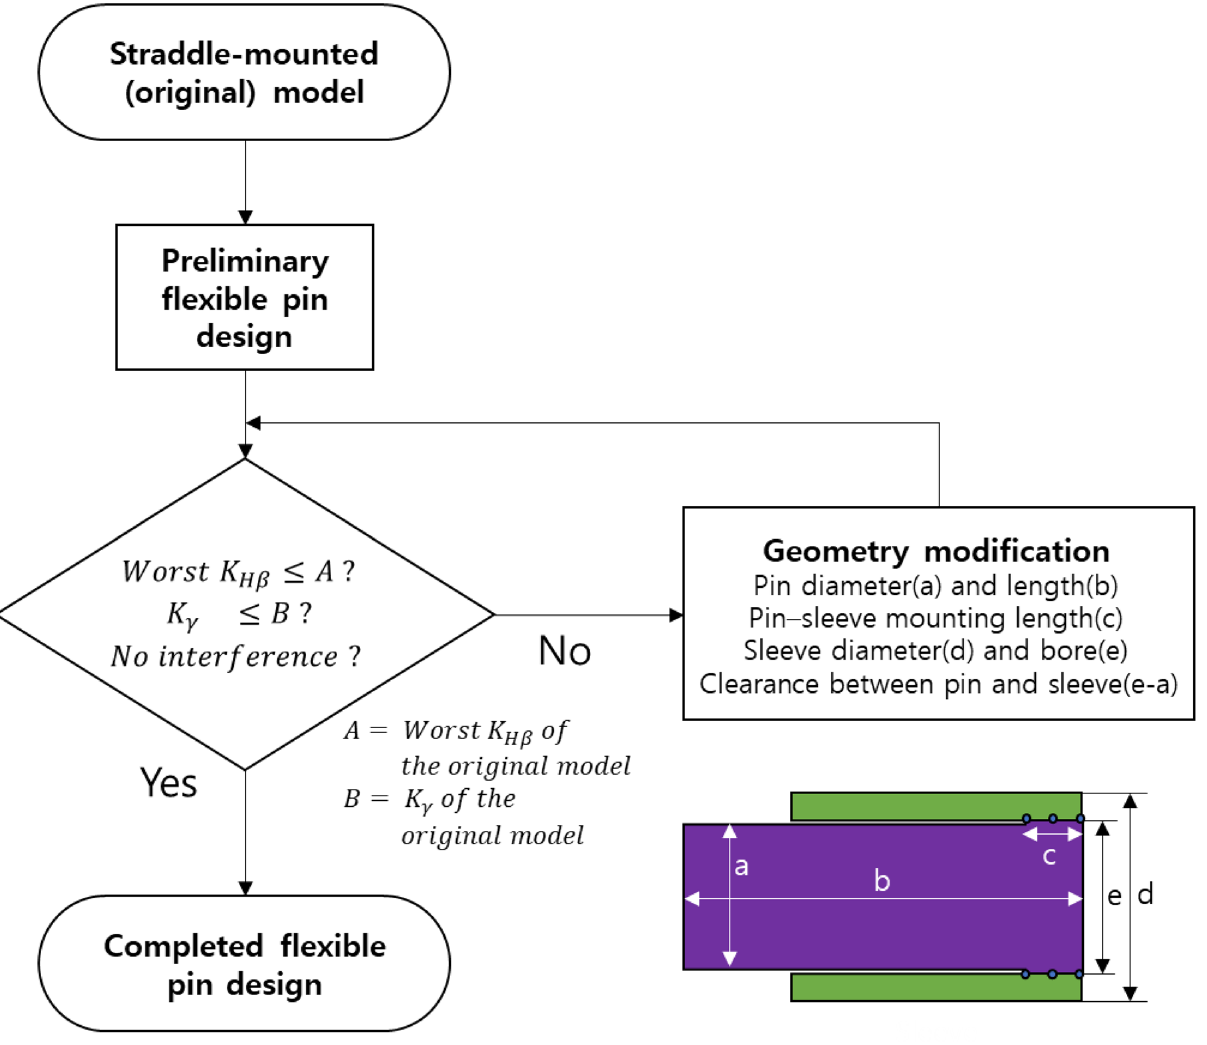
Figure 5. Design process of the flexible pin based on a straddle-mounted pin.